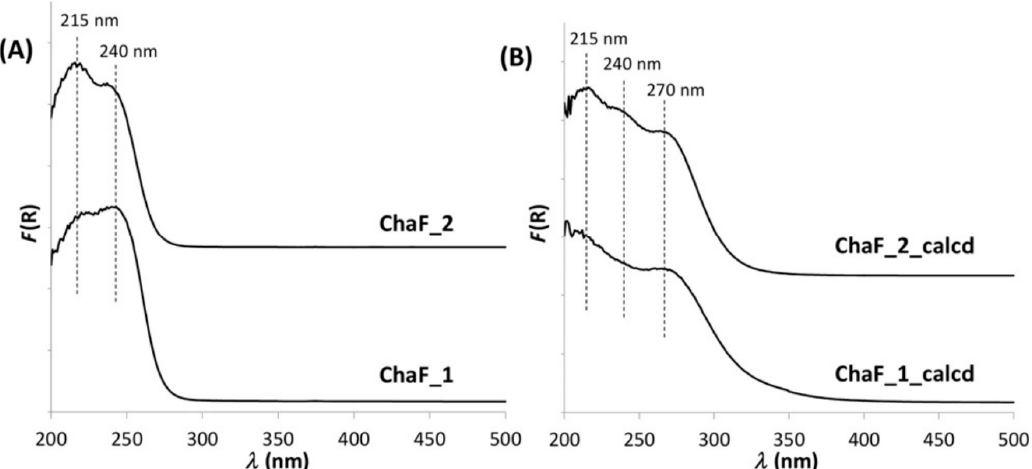
Figure 2. Diffuse-reflectance UV/Vis spectra of the iron-containing CHA zeolites synthesized in Figure 2. Di ff use-reflectance UV / Vis spectra of the iron-containing CHA zeolites synthesized in fluoride fluoride media in their as-prepared (A) and calcined (B) forms. Reprinted with permission from [40]. media in their as-prepared ( A ) and calcined ( B ) forms. Reprinted with permission from [40]. Copyright © 2017 Wiley-VCH Verlag GmbH & Co. KGaA, Copyright © 2017 Wiley-VCH Verlag GmbH & Co. KGaA, Weinheim.